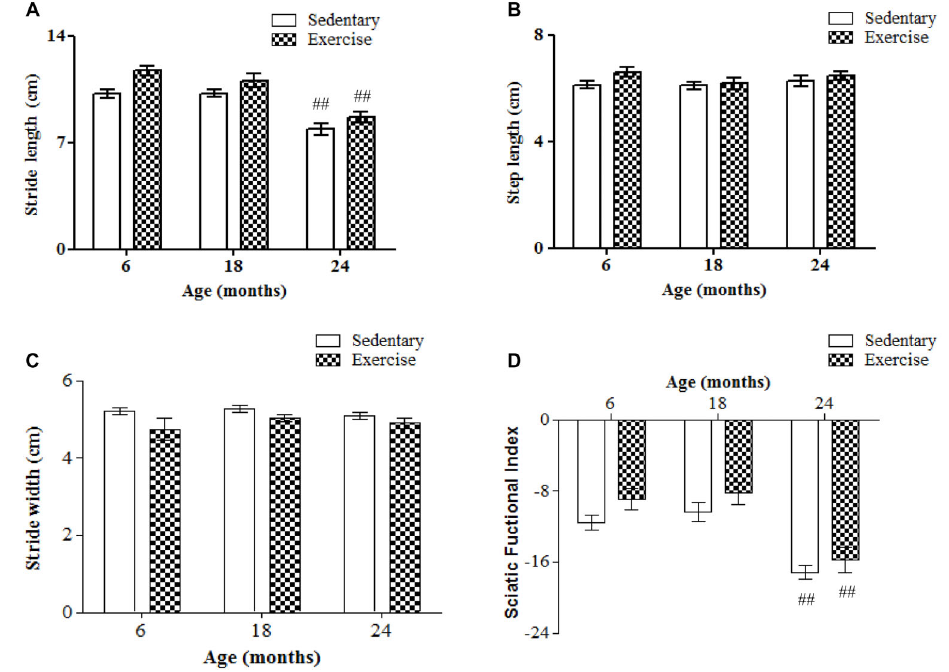
Figure 5. Assessment of stride length ( A ), step length ( B ), stride width ( C ), and sciatic functional index ( D ) of Wistar rats of different ages after 12 weeks of treadmill running. Data are reported as means ± SE. ## P o 0.05 compared to 6- and 18-month-old rats (two-way ANOVA followed by Tukey ’ s post hoc test).